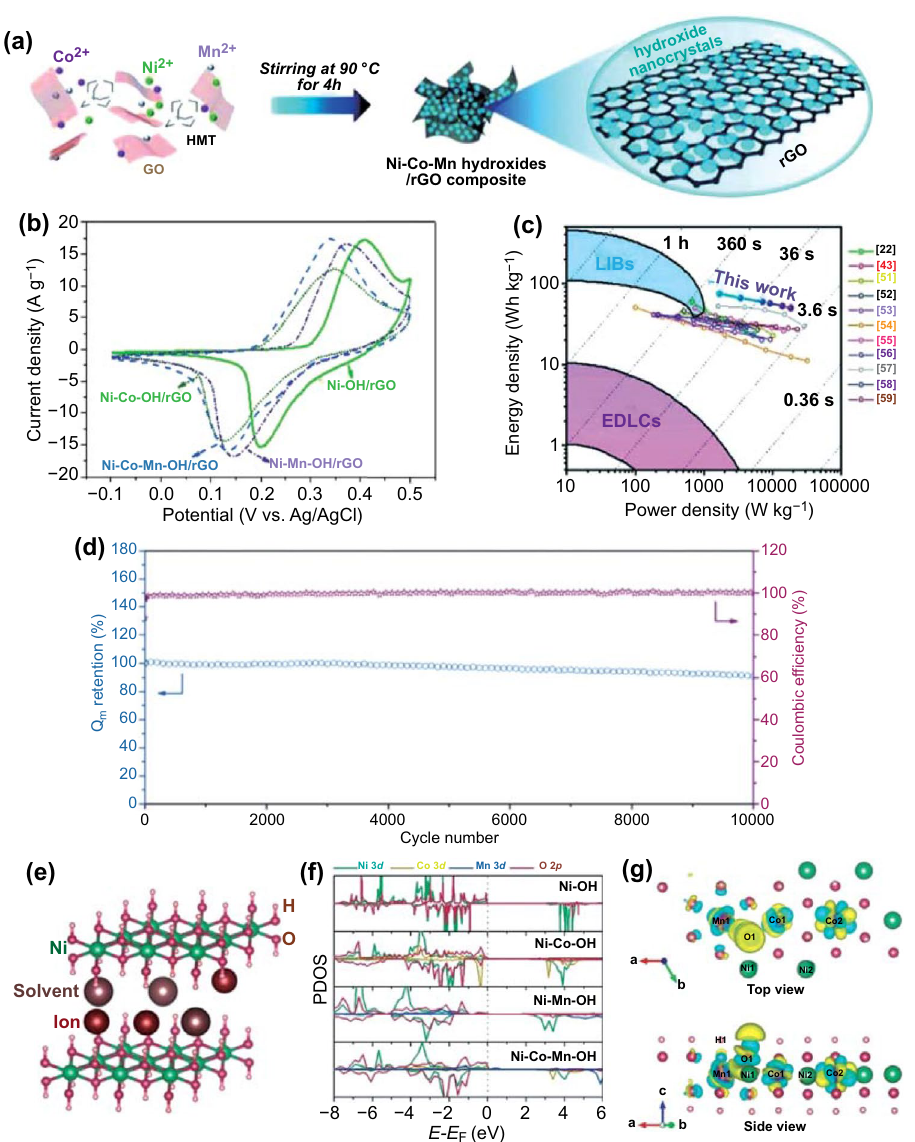
Fig. 13 a Schematic illustration of the preparation of Ni–Co–Mn–OH/rGO. b CV curves at 5 mV s −1 . c Ragone plot of the Ni–Co–Mn–OH/ rGO//PPD/rGO hybrid supercapacitor device. d Cycling performance of the hybrid supercapacitor device at 20 A g −1 . e – g Schematic illustration of nickel hydroxide-layered structure with interlayer species and two possible mechanisms to store charge and density of state (PDOS) diagrams. Adapted with permission from Ref. [130] Copyright 2018